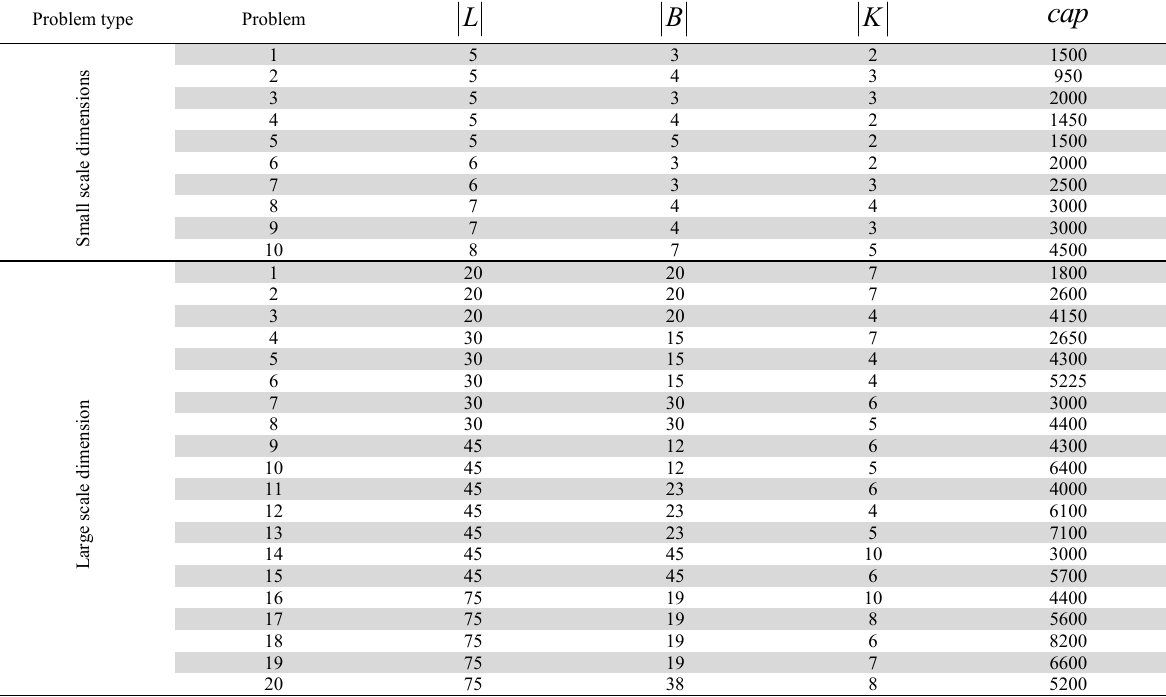
Characteristics of the selected test